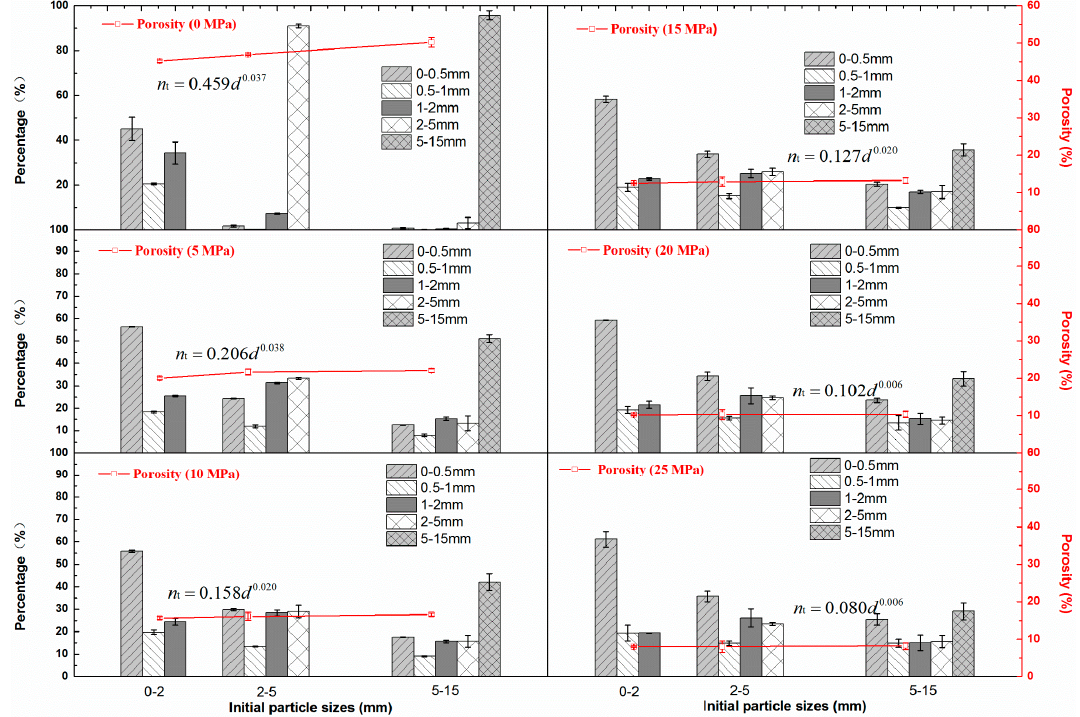
Figure 11. Curves of total porosity change vs. initial particle size and the particle size of the compacted samples.